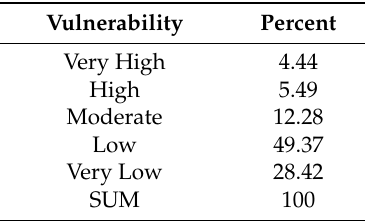
Table 11. The level of residential buildings vulnerability in Tabriz city according to both structural and geotechnical